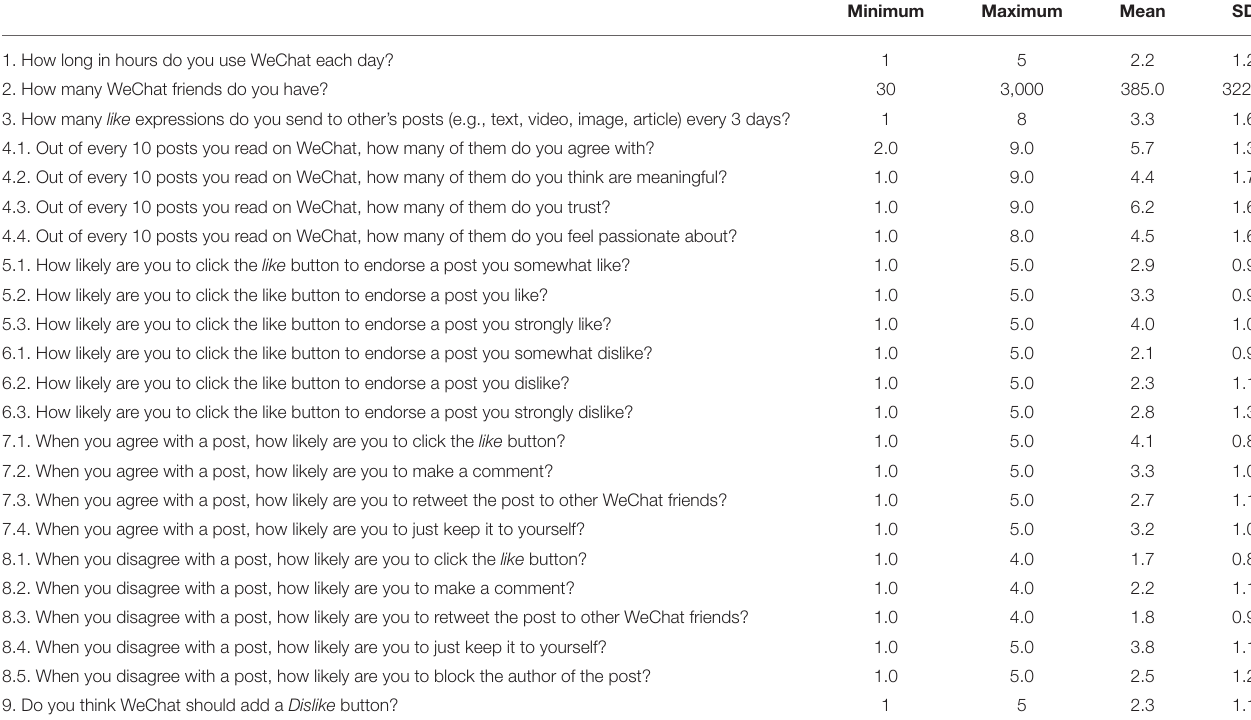
TABLE A1 | A user profile of Liking expressions on WeChat ( n = 168) with descriptive statistics of frequency estimates, likelihood (1 = rare, 2 = unlikely, 3 = possible, 4 = likely, 5 = almost certain) and agreement (1 = agree and 5 = disagree) ratings on a 5-point scale.